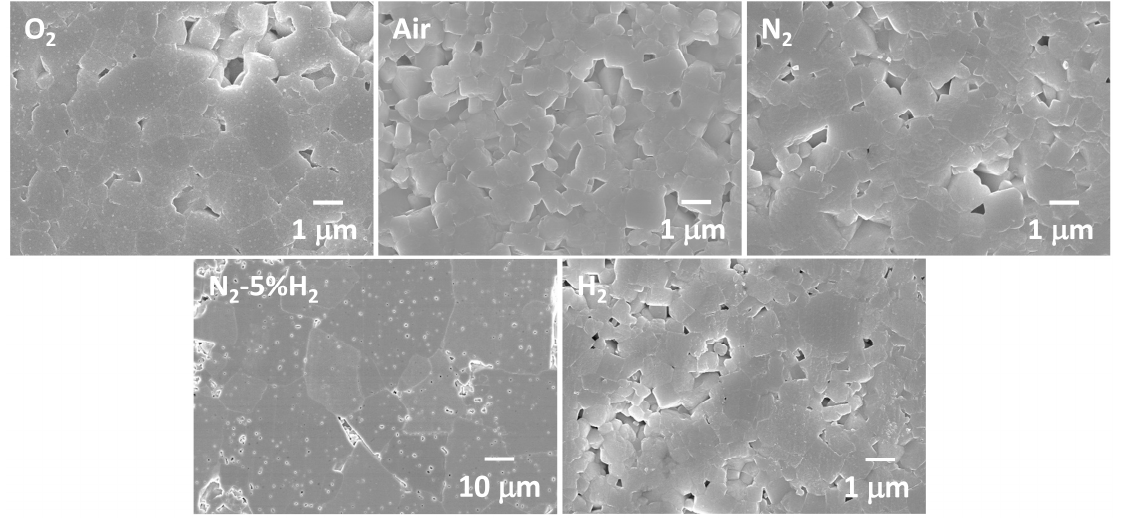
Figure 3. SEM micrographs of KNbO 3 samples sintered at 1040 °C for 3 h in different atmospheres.